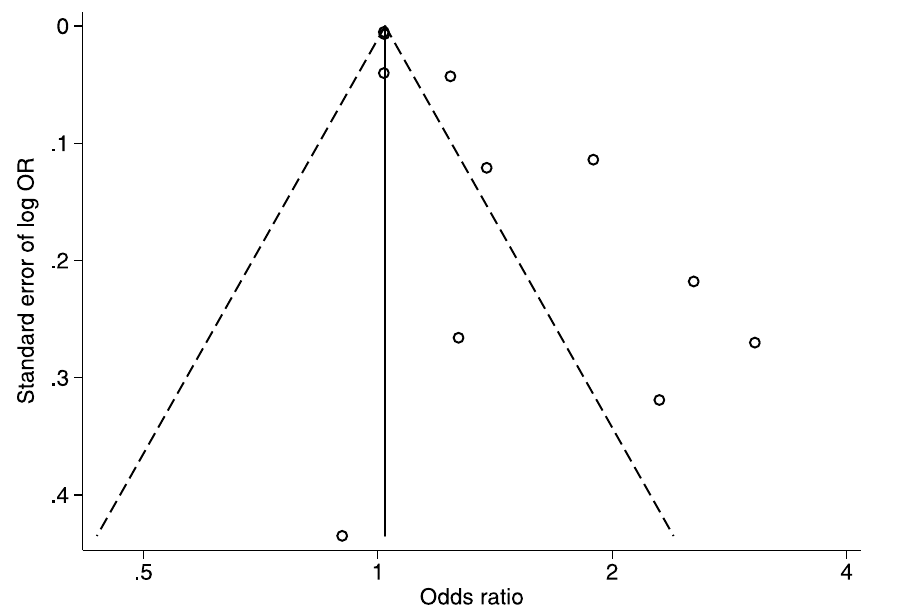
Fig 3. Funnel plot with pseudo 95% confidence limits of studies reporting an association between near work and prevalence of myopia. The funnel plot showed that the distribution of studies was asymmetrical compared to summary estimates.